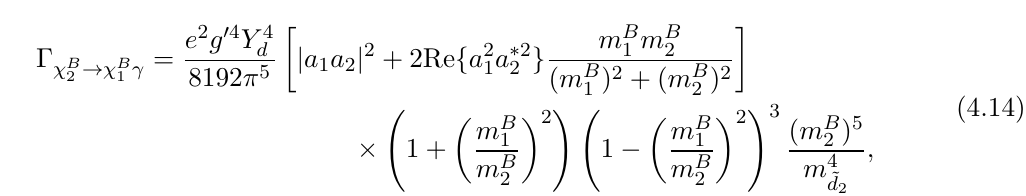
to (cid:31) B and a 2 1